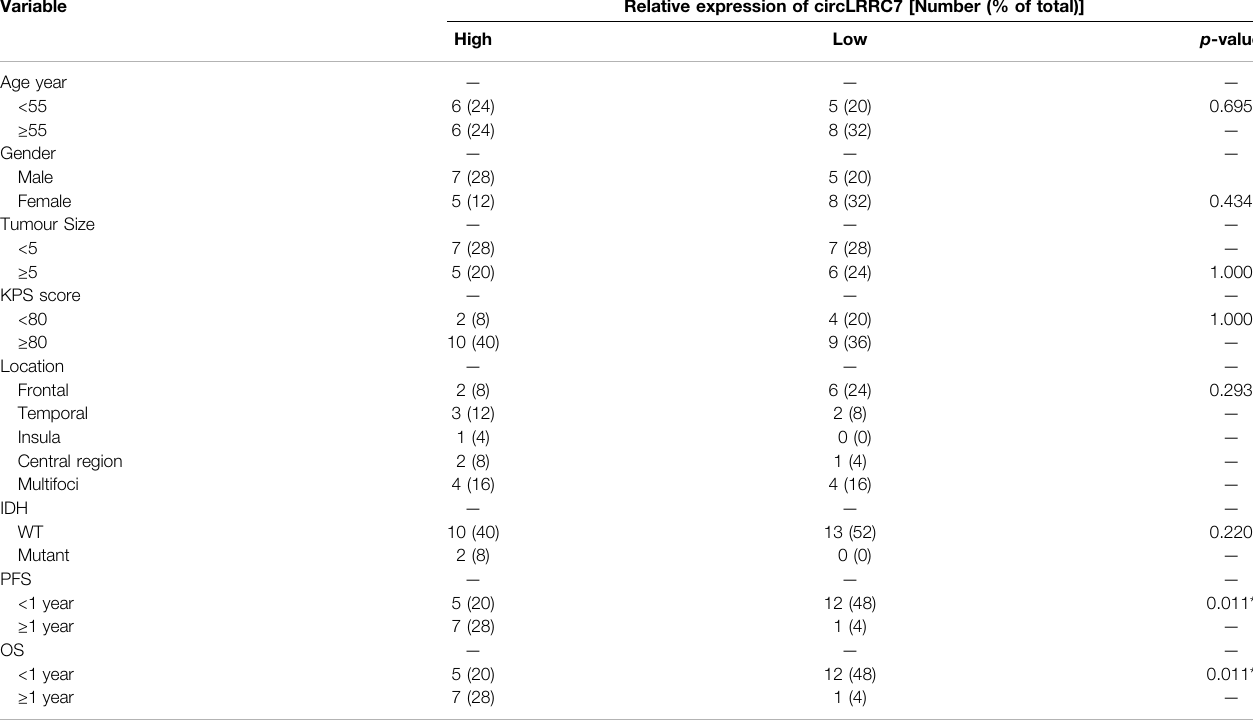
Asterisks indicate statistical signi fi cance. * p ≤ 0.05.